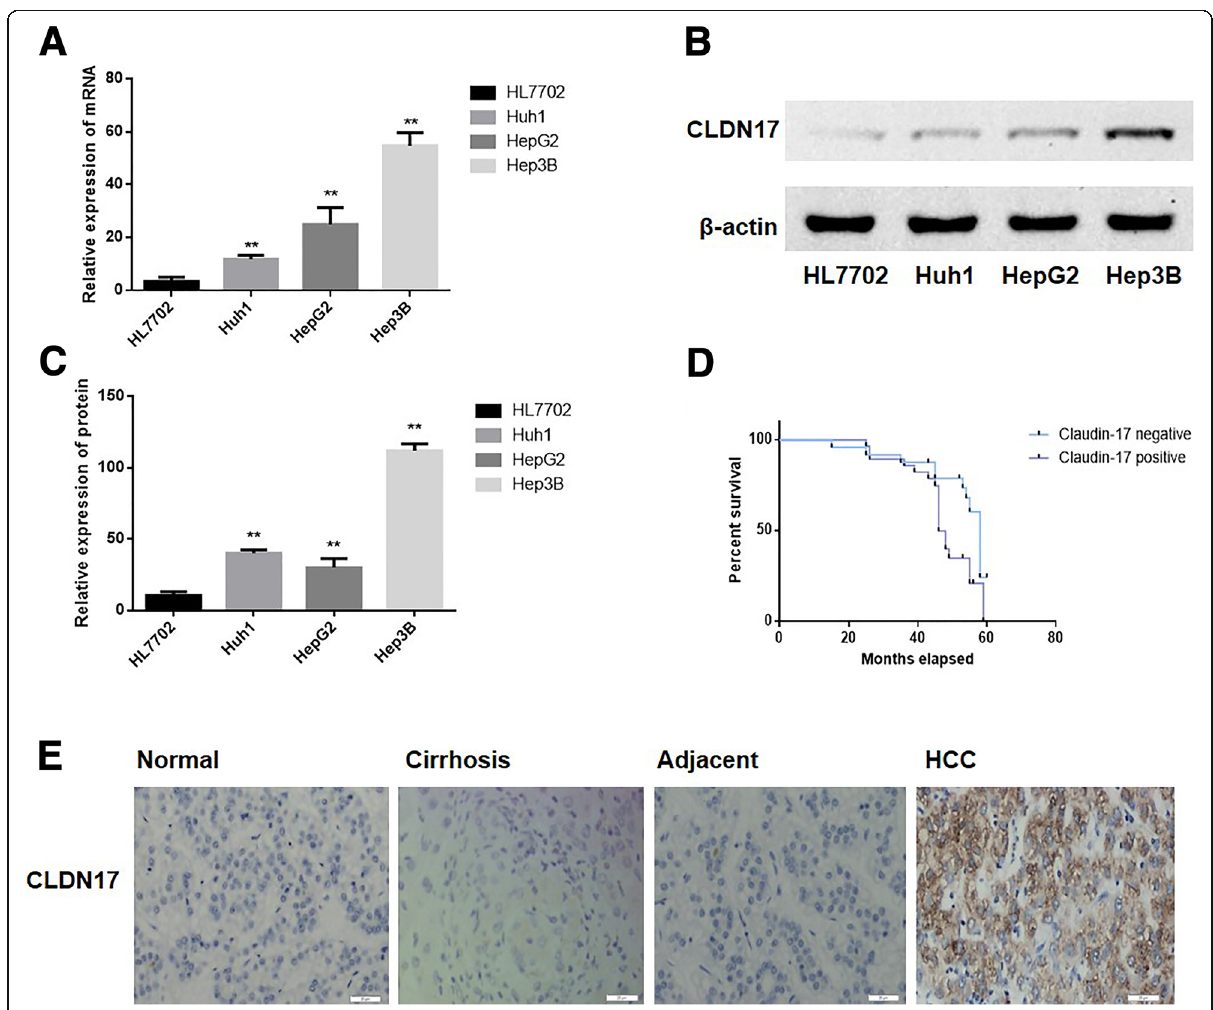
Fig. 1 The expression levels of CLDN17 in HCC cell lines and tissues. a The relative mRNA level of CLDN17 in the hepatocyte line and HCC cell lines; ( b ) The relative protein expression of CLDN17 in the hepatocyte line and HCC cell lines; ( c ) The corresponding statistical analysis of protein expression in the hepatocyte line and HCC cell lines; ( d ) The correlation between the expression of CLDN17 and survival in HCC patients; ( e ) The protein expression of CLDN17 in hepatocyte tissues, cirrhosis tissues, tissues adjacent to the tumors and HCC tissues. Note: * represents P < 0.05, ** represents P < 0.01, compared with the empty vector